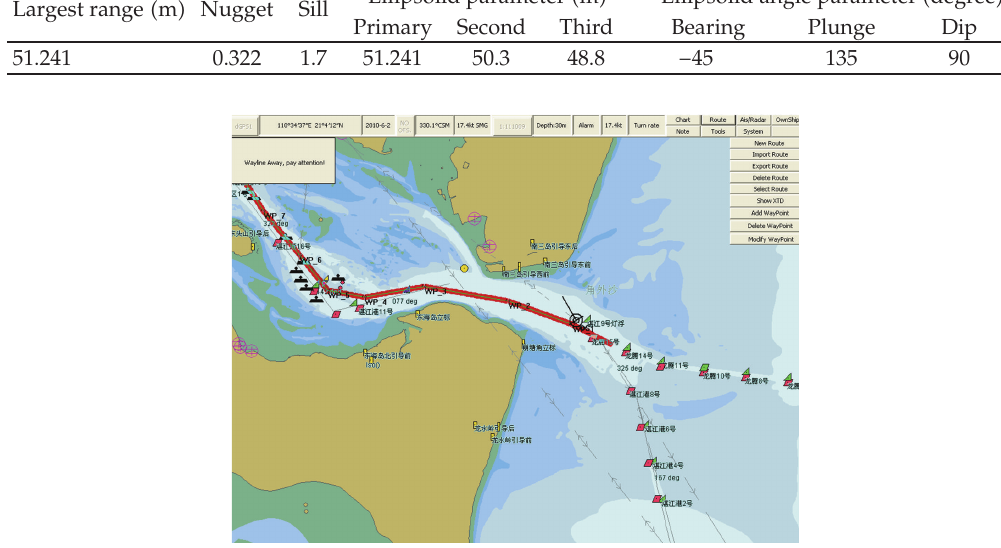
Figure 5: Simulation of ownership outside of planning